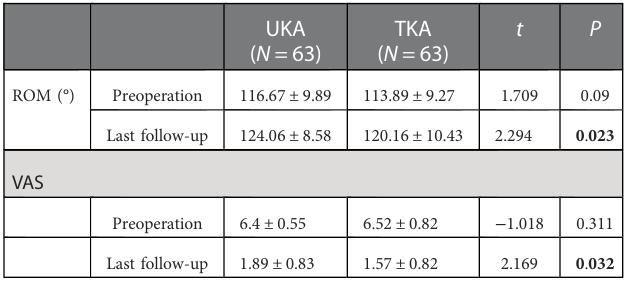
TABLE 4 ROM and VAS scores in two groups.